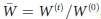
Time evolution of the normalized wound width W-=W(t)/W(0) for (a) the ctr cells (●) and (b) the ko cells (○), where the red symbols represent simulations.